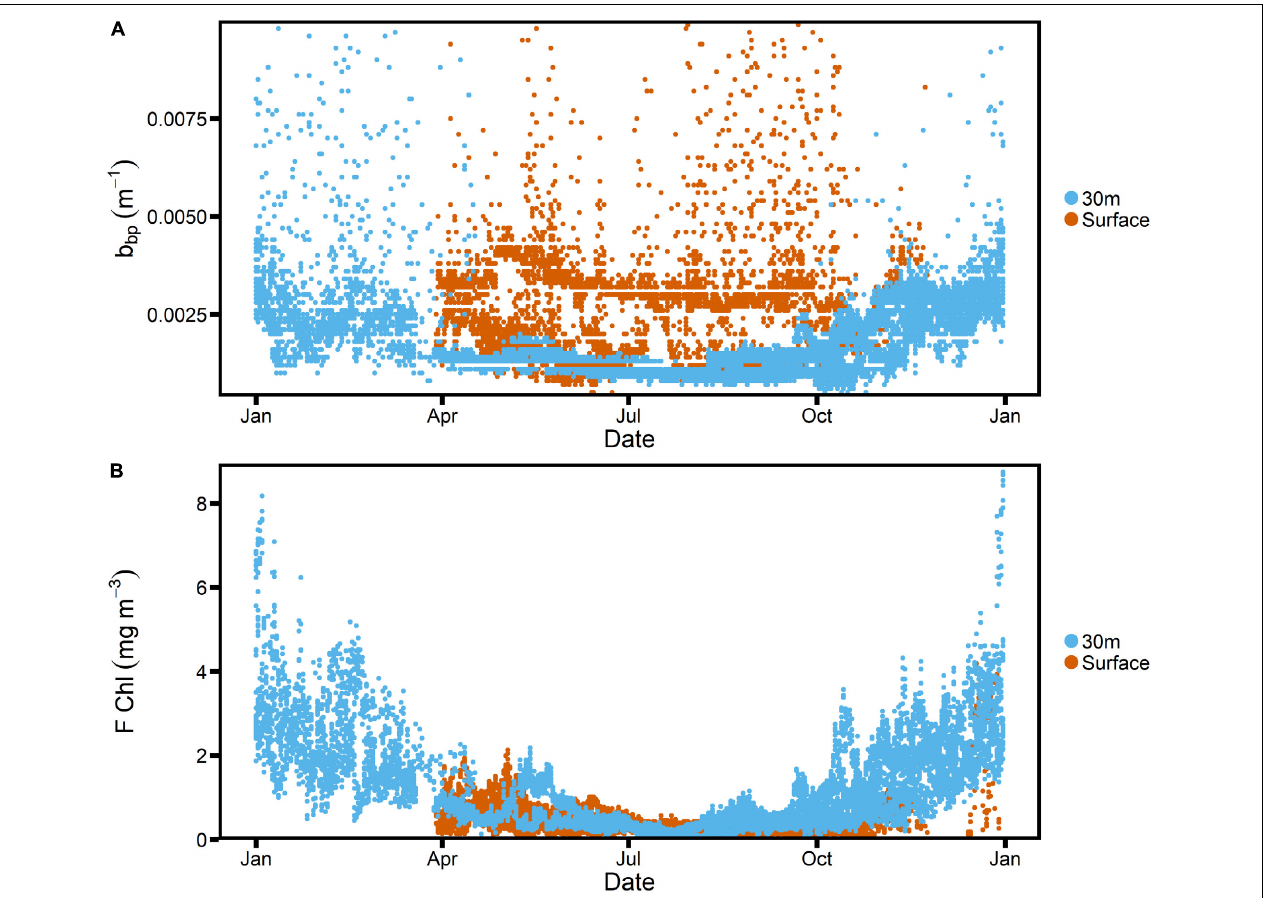
FIGURE 2 | Particulate backscatter (A) and chlorophyll fluorescence (B) from all SOTS deployments, comparing surface values to those at a depth of 30